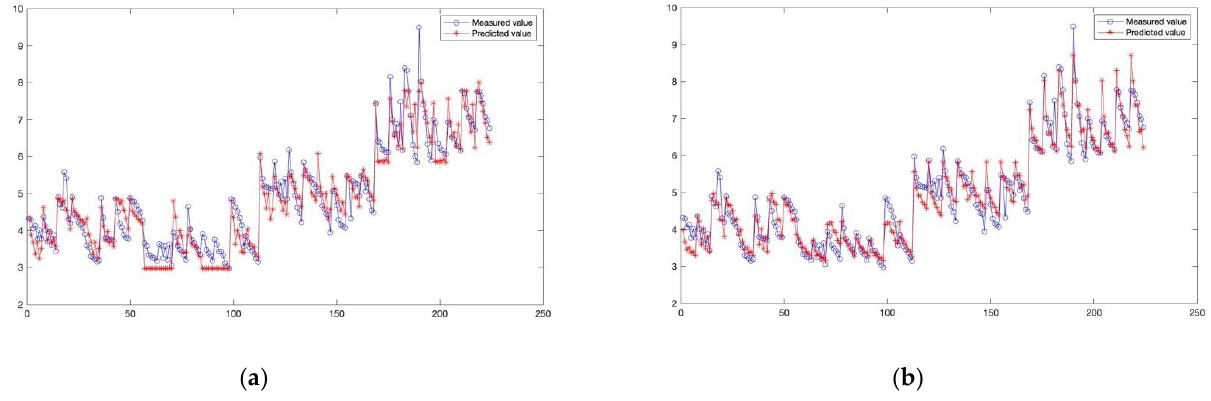
Figure 12. The comparison between the actual value of the surface roughness (Ra) and the predicted value of the BP ( a ) and the CPA-BP ( b ) model is shown in Figure 12.